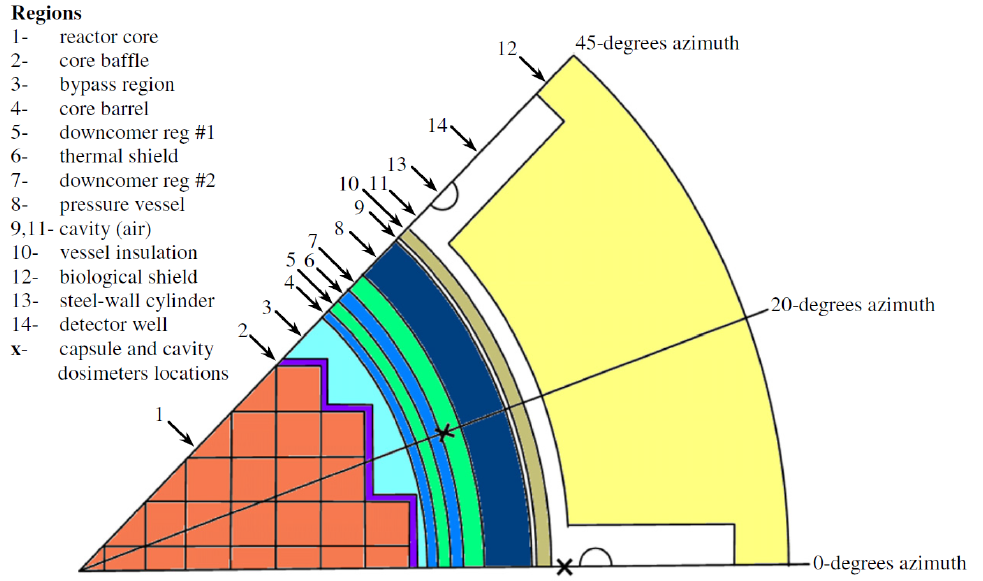
Figure 2. Schematic radial cut of an octant of the H.B. Robinson-2 (taken from